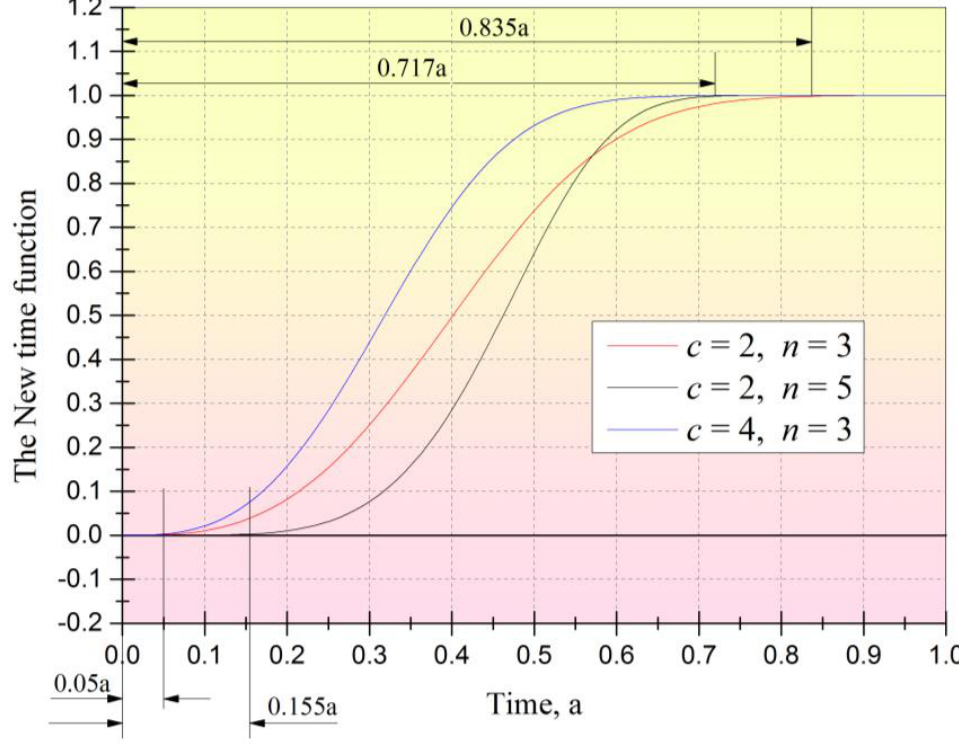
Figure 5. Adaptability analysis of new time function.